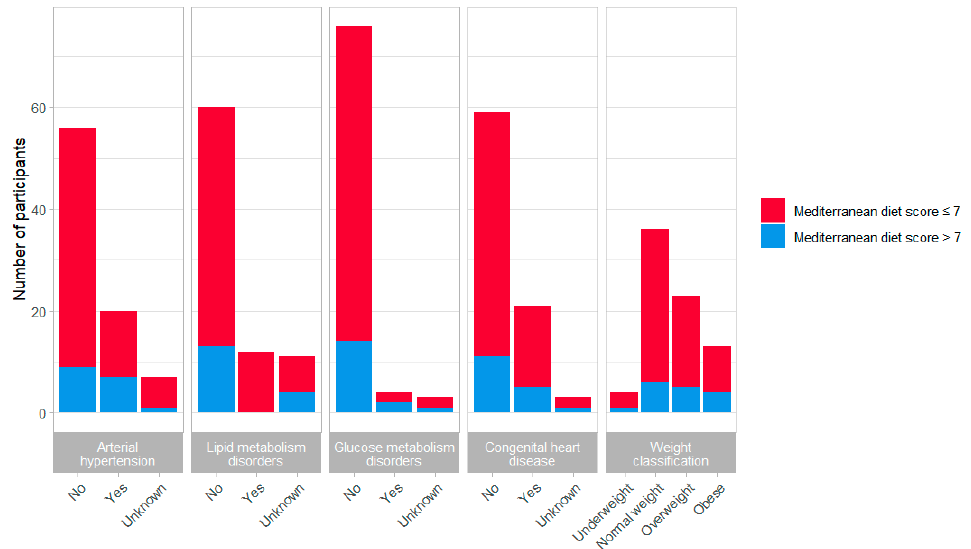
Figure 3. Low (score ≤ 7) and high (score > 7) adherence to the Mediterranean diet relative to cardiovascular morbidity in Turner syndrome patients. Chi-squared tests or Fisher’s exact test for counts smaller than five were applied to test for significance.